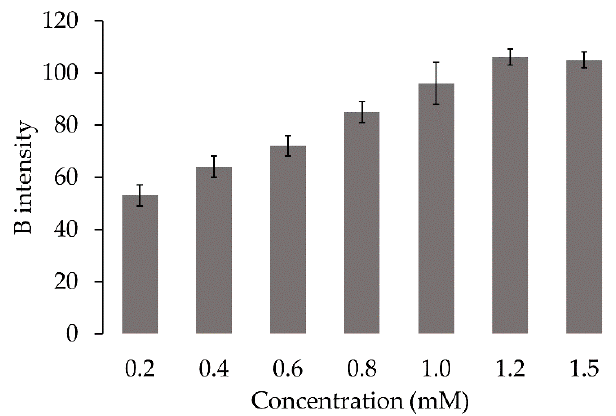
Figure 3. Effect of Acid Red 27 concentration.